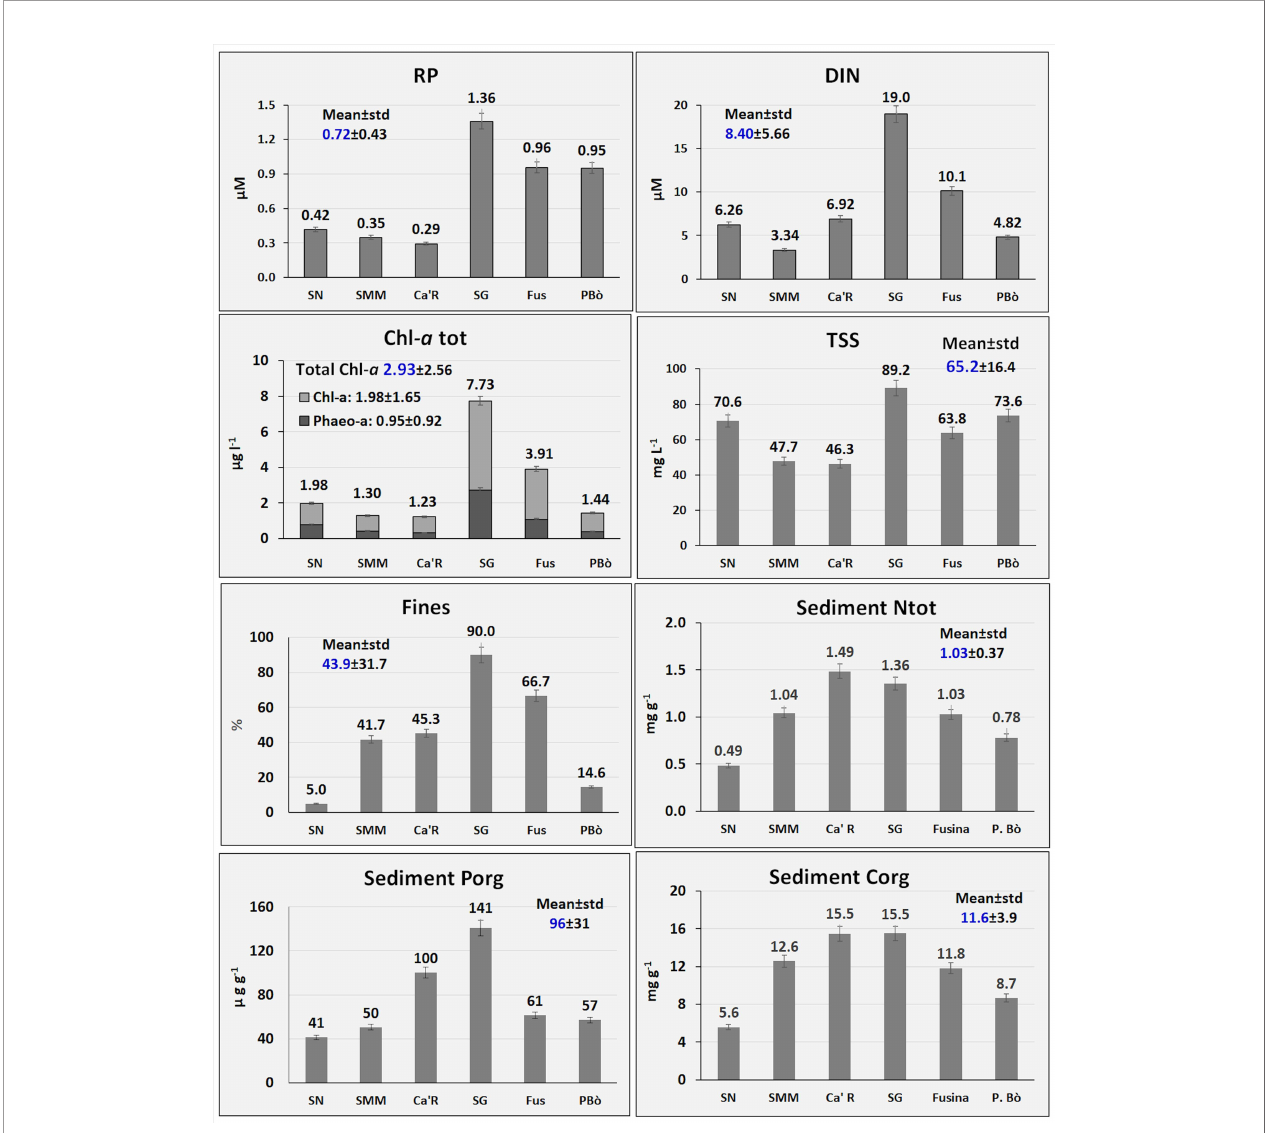
FIGURE 2 | Main ecological